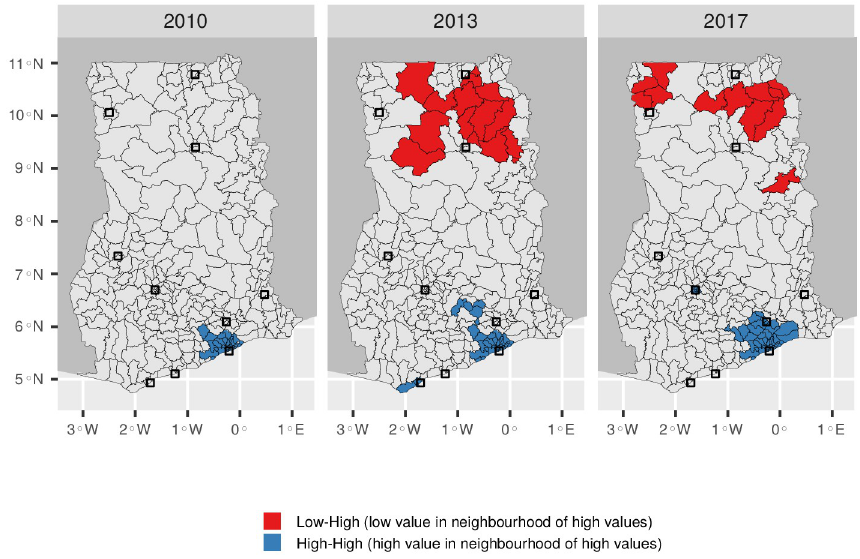
Fig 6. Local Indicators of Spatial Association clusters for Ghana in 2010, 2013 and 2017. Maps were created with data from the Humanitarian Data Exchange [33], which are made available under a CC-BY license [34]. For copyright reasons the district boundaries shown are from the present day ( n =